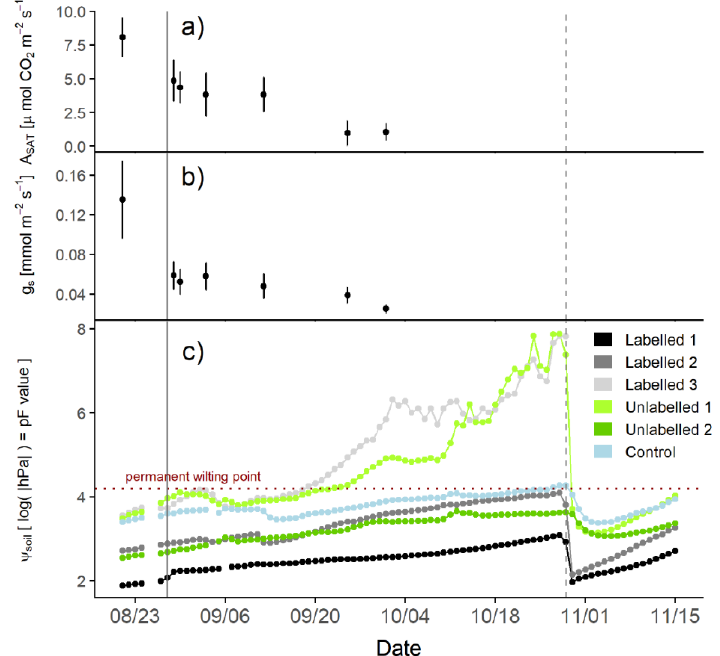
Figure 3. ( a ) Time series of light-saturated photosynthesis (A sat ) and ( b ) stomatal conductance (g s ) of beech seedlings as measurement averages ± standard error ( n = 5). ( c ) Soil matrix potential in beech compartments (daily means) as pF-values, log( | hPa | ) for three labelled (black, grey, light grey), two unlabelled (green, light green), and one unplanted control (light blue) mesocosms. Solid vertical line: time of deuterium labelling; dotted vertical line: re-watering of beech compartments. Very high pF values of some replicates from 10 April onwards were likely related to volumetric-water-content (VWC) measurement bias in very dry soil conditions.